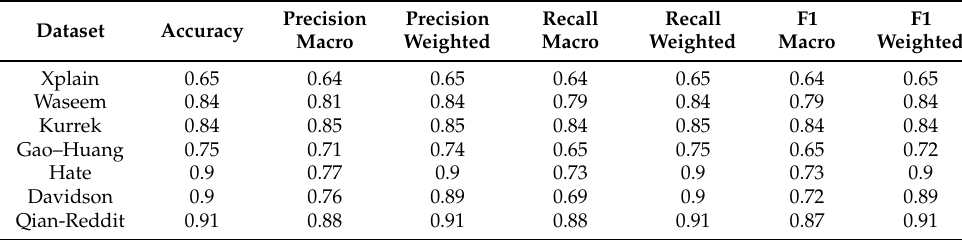
Table 5. MTL (hard) RoBERTa token